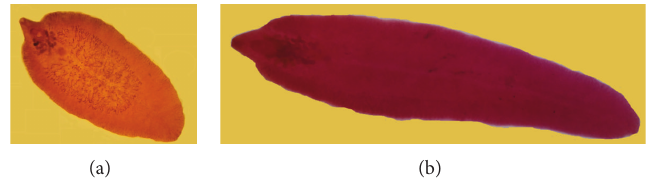
Figure 2: Fasciola hepatica (a) isolated from sheep and Fasciola gigantica (b) isolated from cattle.